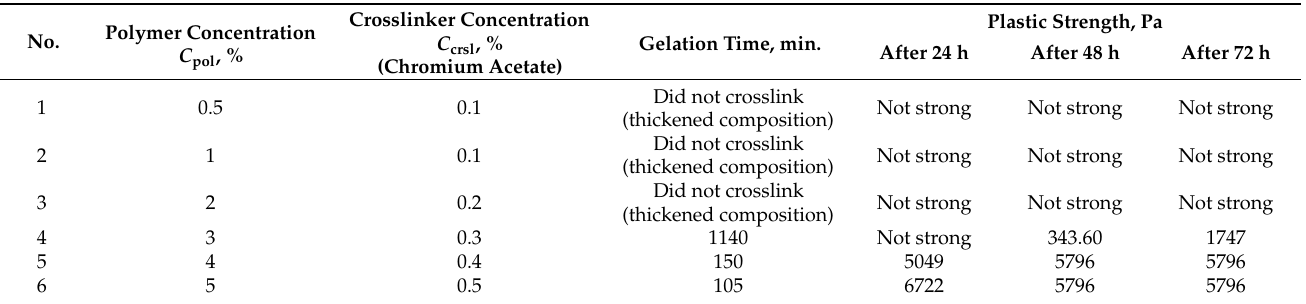
Table 2. Results of determining the plastic strength and gelation time of the polymer composition, based on the HPAN and chromium acetate.